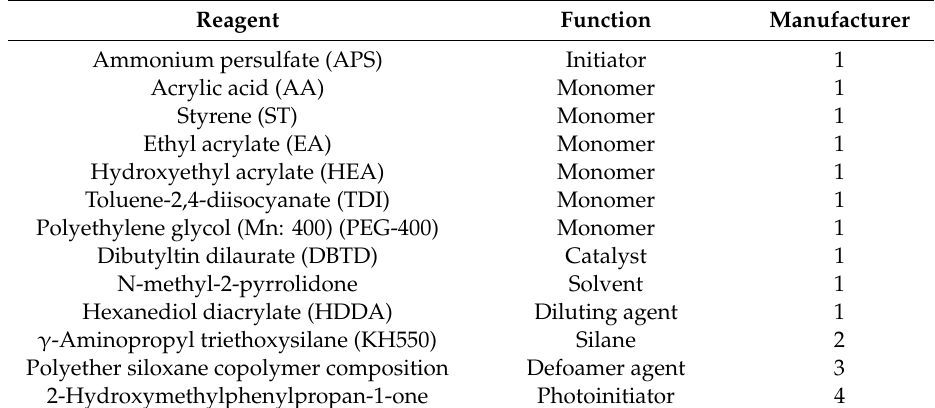
Table 1. Reagents for water-based UV curing PUA coating. Reagent Function